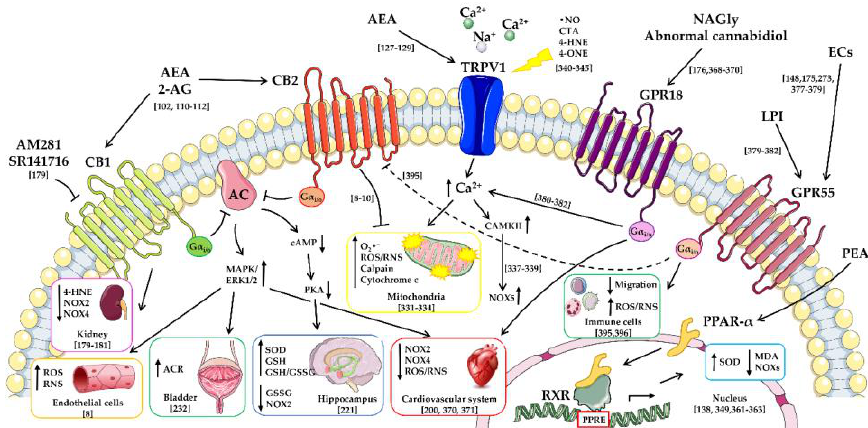
Figure 5. Role of endocannabinoids (ECs) and their lipid analogues in modulating reactive oxygen and nitrogen species (ROS/RNS) and reactive aldehydes formation. AM281: 1-(2,4-dichlorophenyl)-